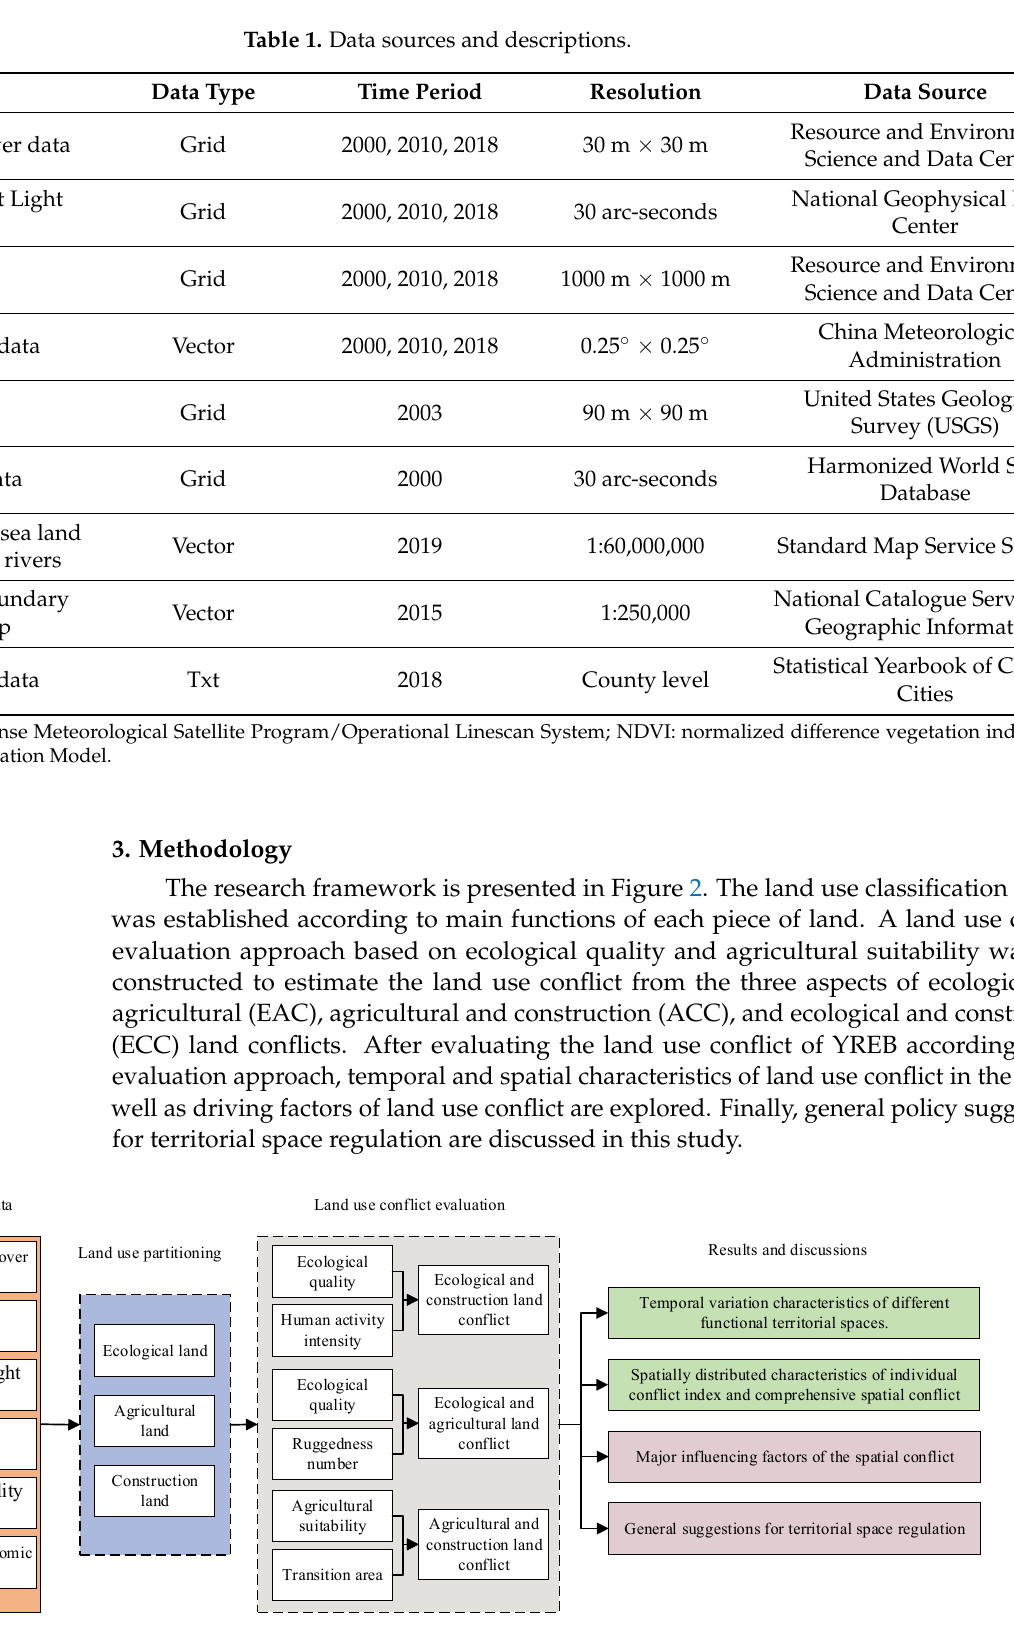
Figure 2. Research framework.